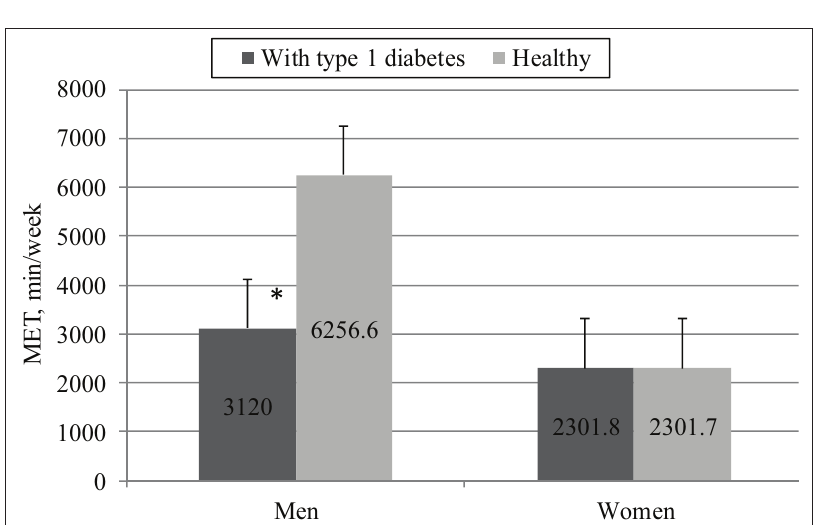
Figure 3. Physical activity of healthy and subjects with diabetes type 1 in MET values Figure 4. High physical activity assessed in MET values in the healthy and diabetes